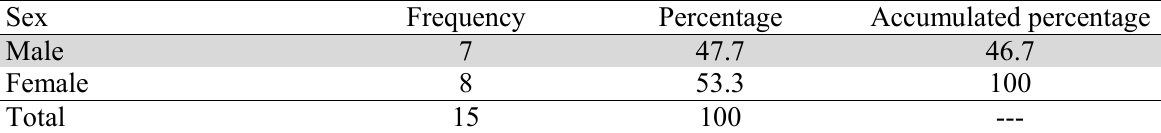
Distribution of the experiment group based on sex Sex Frequency